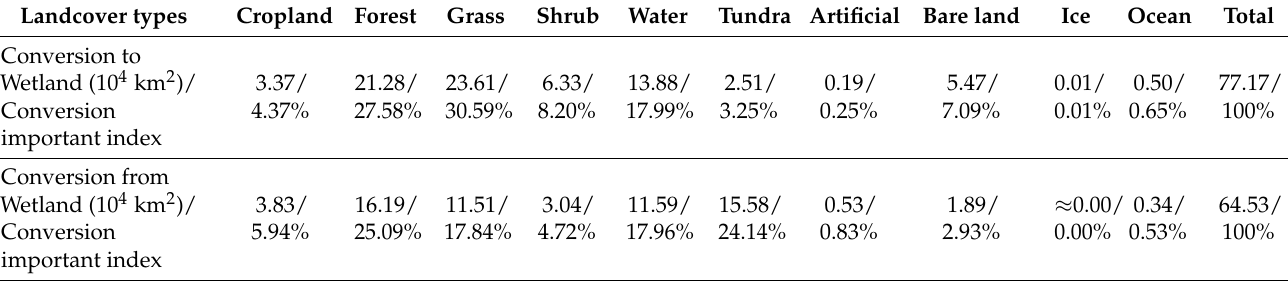
Figure 4. Global conversions between wetland and other land cover types, 2000–2020. Table 2. Conversions between wetlands and other land cover types from 2000 to 2020.